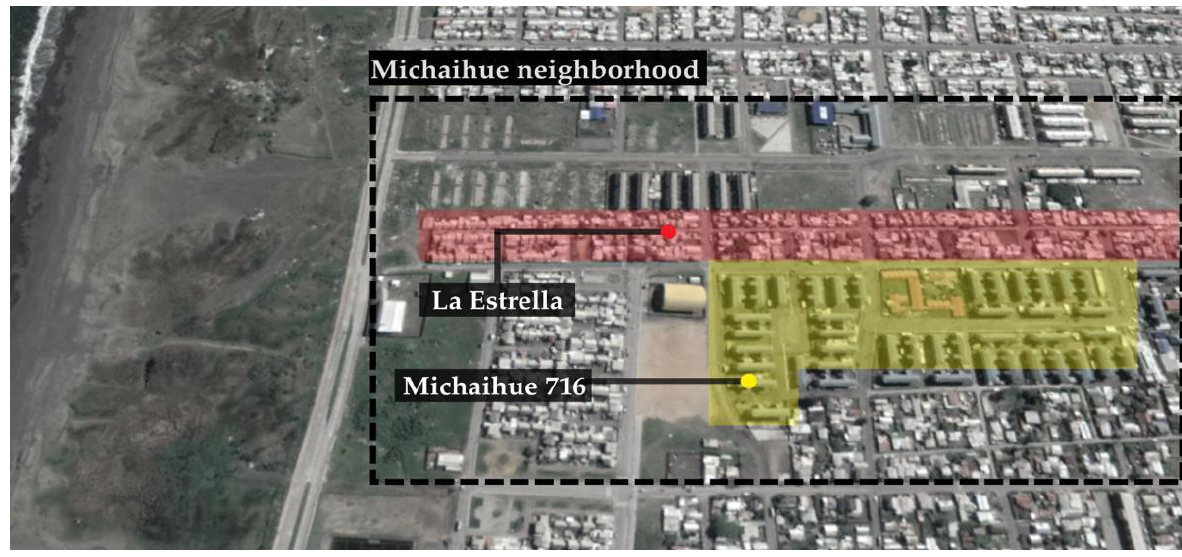
Figure 1. Aerial Photo of the Case Study.